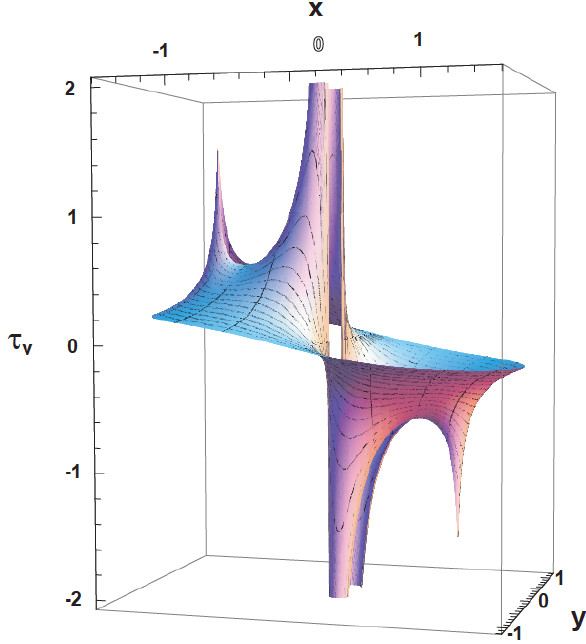
Figure 4: Shear stress for elliptical hole in the v-direction